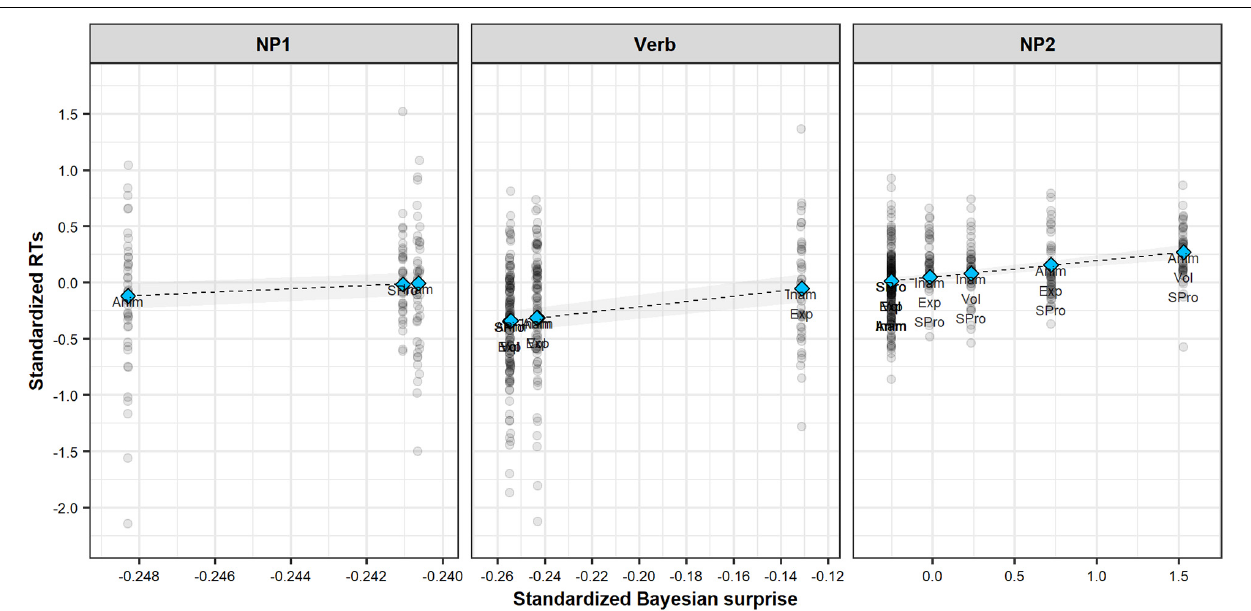
FIGURE 5 | Bayesian LMM MAP estimates of standardized RTs in each sentence region as function of standardized Bayesian surprise. Shaded areas illustrate 89% HPDIs. Shaded dots represent individual item-level RTs. Texts describe item-level sentence properties. Anim: animate; Inam: inanimate; Pro: pronominal; S: subject; O: object; Vol: volitional; Exp: